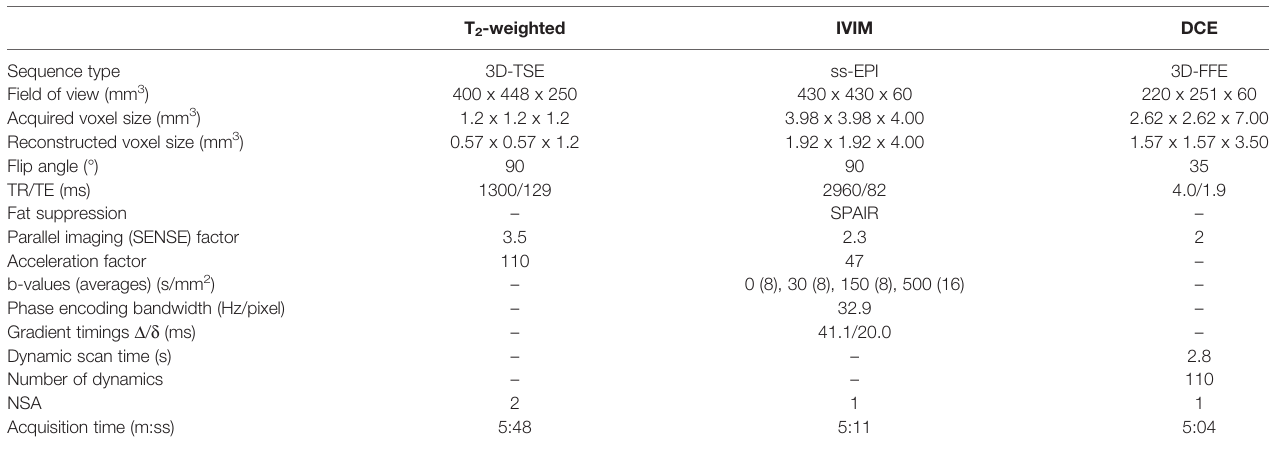
TABLE 2 | MRI sequence